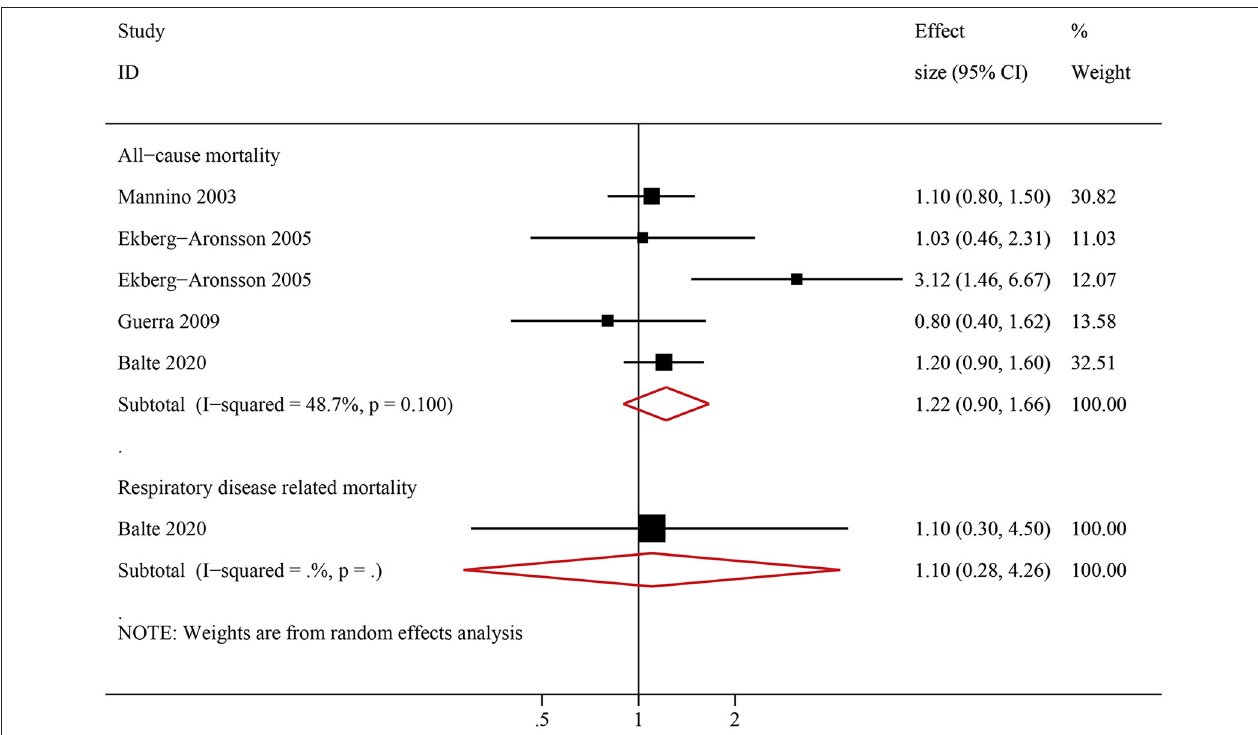
FIGURE 5 | Forest plot of the risk of all-cause mortality and respiratory-related mortality in never smokers with non-obstructive chronic bronchitis compared with never smokers without non-obstructive chronic bronchitis. Without non-obstructive chronic bronchitis was defined as normal spirometry and no chronic